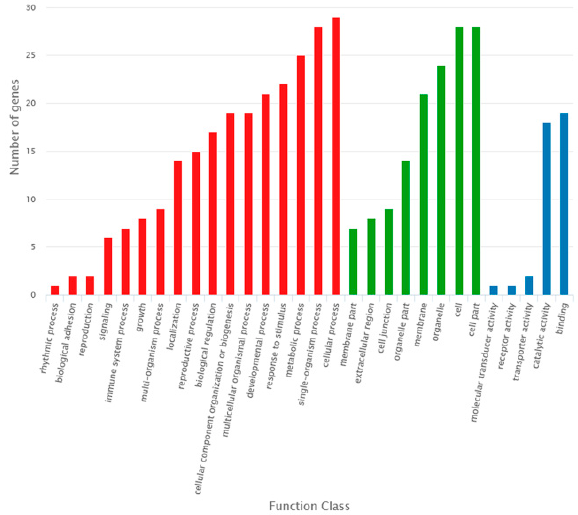
Figure 10. Gene ontology classification of potential targets of miRNAs in the DEmiRNA–DEmRNA network in Bcajh97-01B (fertile line) and Bcpol97-05A (sterile line) of Brassica Table 6. Differentially expressed miRNAs and their target genes in the DEmiRNA–DEmRNA net- work involved in anther development in Bcajh97-01B (fertile line) and Bcpol97-05A (sterile line) of Brassica campestris .